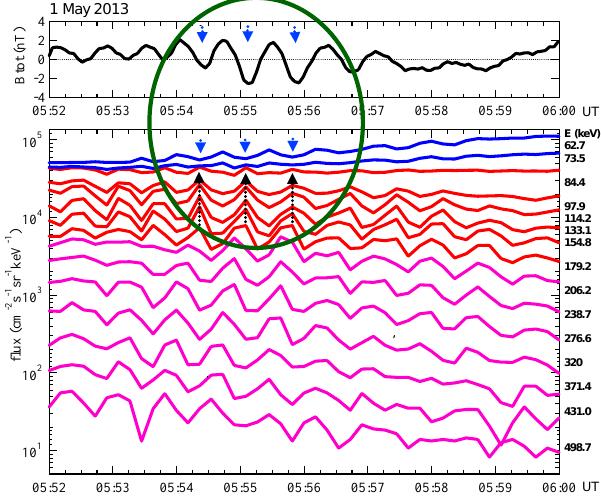
Figure 9. Expanded plot of observations of the total magnetic field strength (smoothed) and the proton fluxes in the range of energies from 62.7 to 498.7keV from 05:52 to 06:00UT. Upward (black) and downward (blue) arrows show the sense of variations in Btotal and particle fluxes at energies ranging from 62.7 to